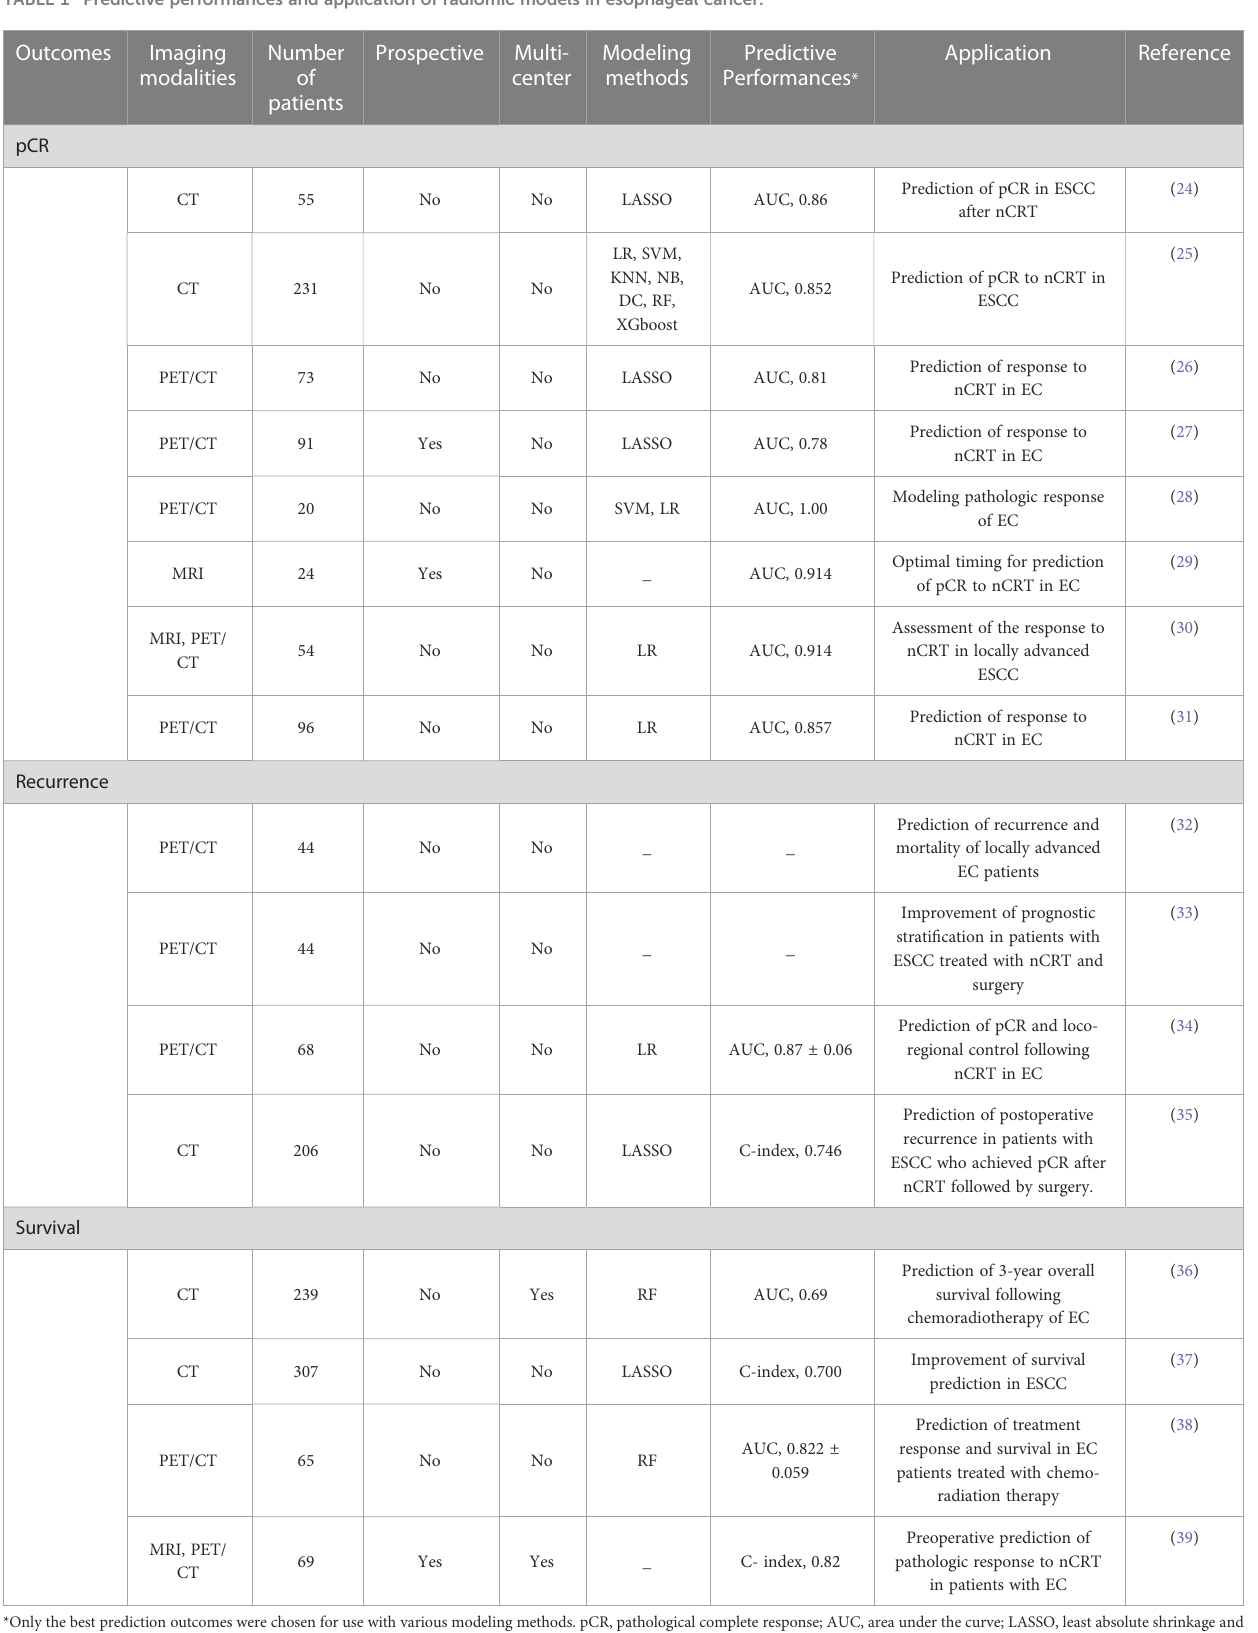
TABLE 1 Predictive performances and application of radiomic models in esophageal